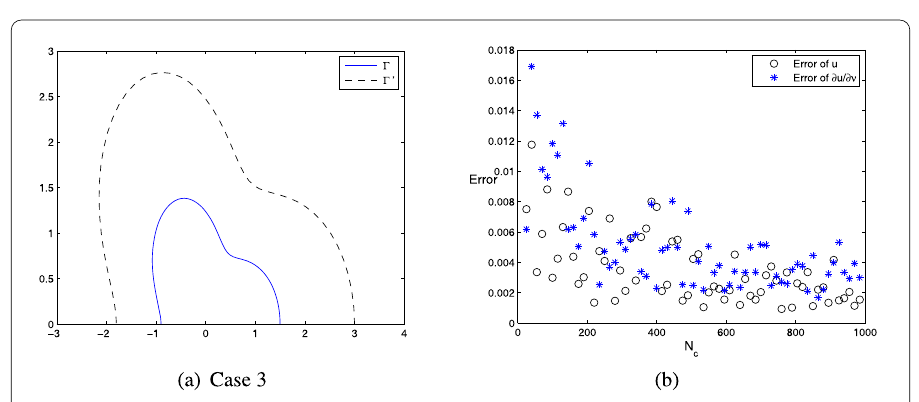
Figure 4 ( a ) Sketch of case 3. ( b ) The relative errors on Γ 2 with different choices of N c ∈ [25,985]